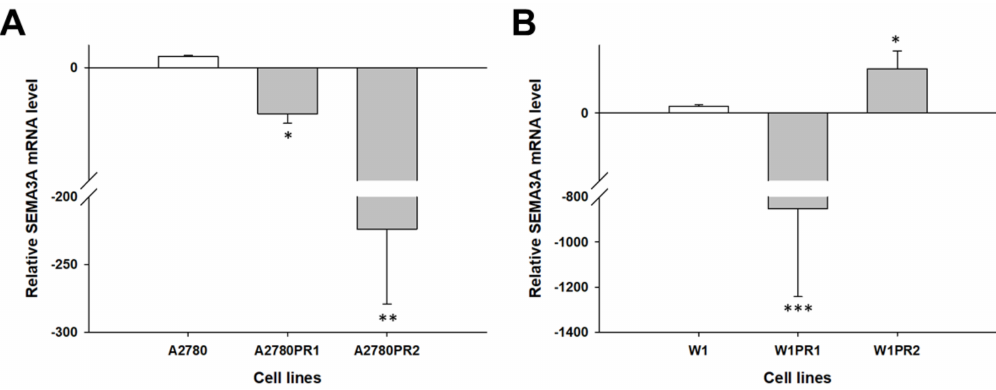
Figure 4. Expression analysis (Q-PCR) of the SEMA3A gene in the A2780 ( A ) and W1 ( B ) PAC-resistant cell lines. The figure presents the relative gene expression in the resistant cell lines (grey bars) with respect to that of the sensitive cell line (white bars), which was assigned a value of 1. The values were considered significant at * p < 0.05, ** p < 0.01 and *** p < 0.001.